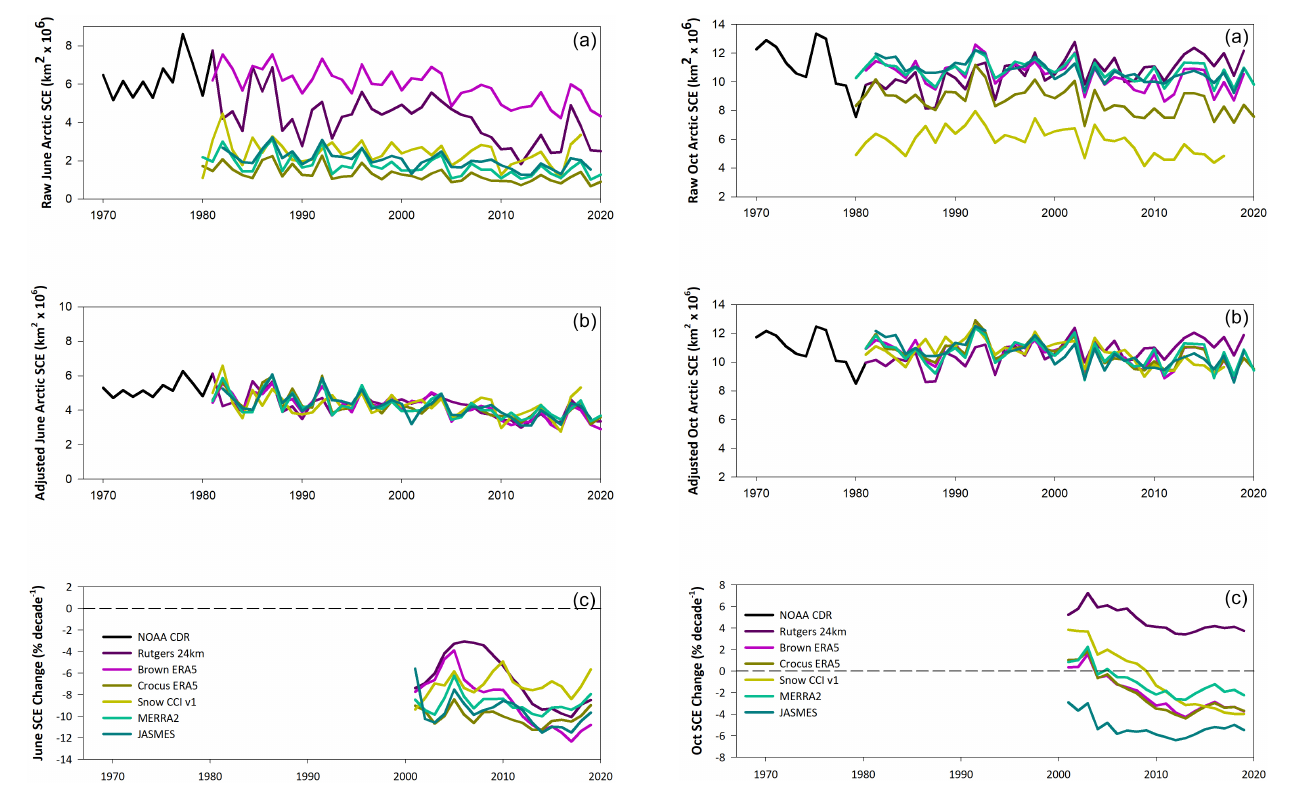
Figure 2. As in Fig. 1 but for June. Figure 3. As in Fig. 1 but for October. Table 2. Summary of reference